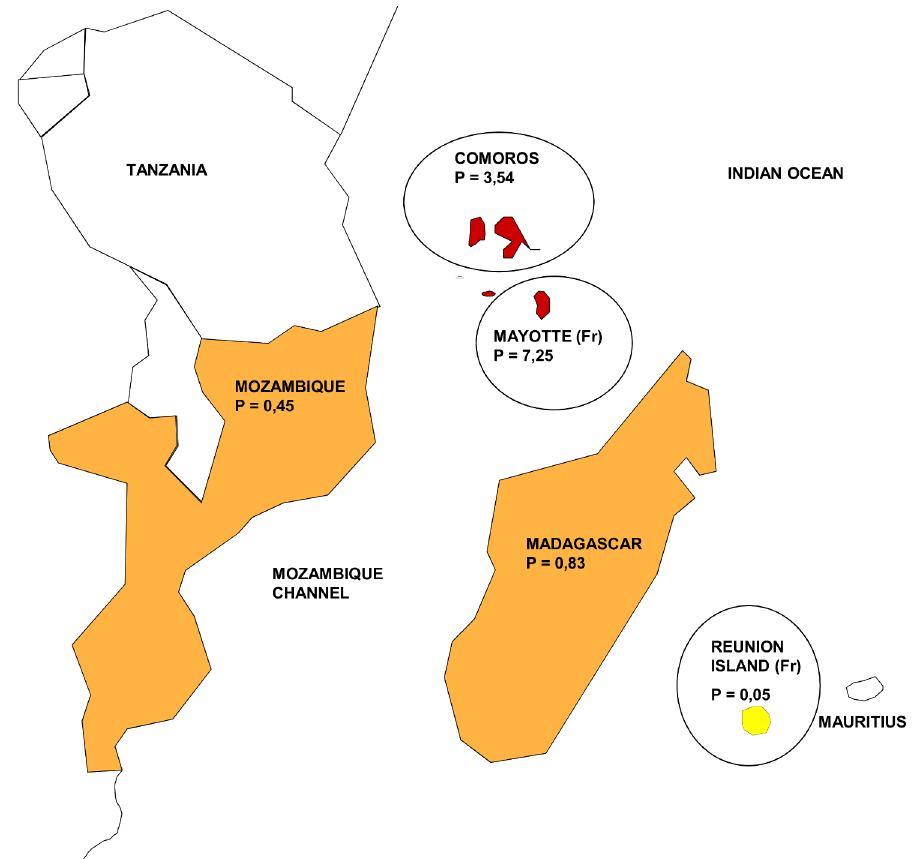
Fig 1. Prevalence rate of Leprosy in Indian Ocean in 2014. P (Prevalence rate) = number of cases/ 10 000 inhabitants; Fr = French Oversea Departments; For Tanzania and Mauritius: No data available; For Mozambic, Madagascar and Comoros: data from the Weekly Epidemiological record, Sept 2015; For Reunion and Mayotte islands: data from the ALLF (association of francophone leprologists) bulletin N°30, June 2015; Red = highly endemic; orange = endemic; yellow = eradicated.